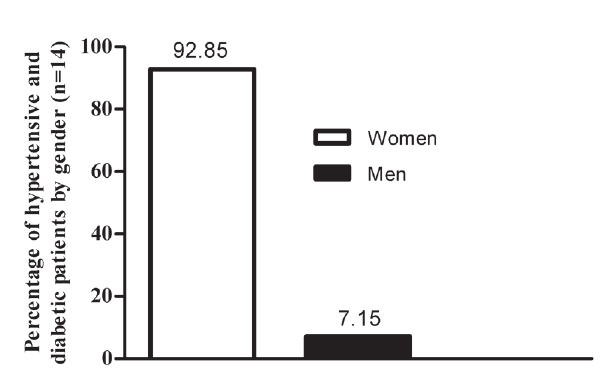
FIGURE 3 – Percentage (%) of hypertensive and diabetic patients by gender (n=14), related to the total number of study participants, n=16.